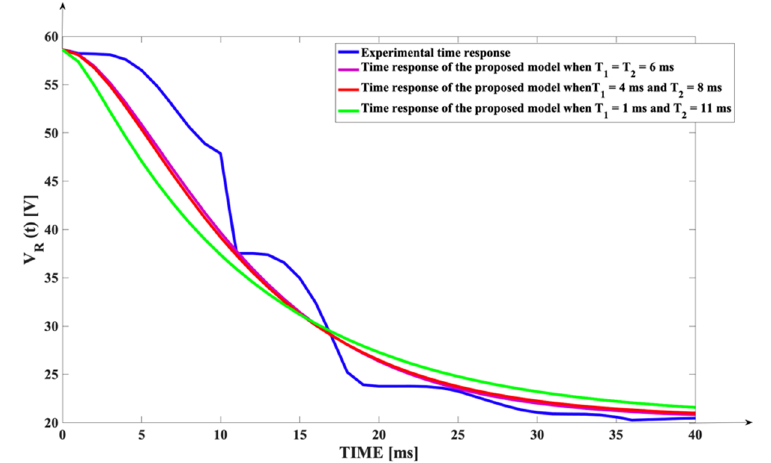
Figure 5. Different answers of the proposed second-order model.